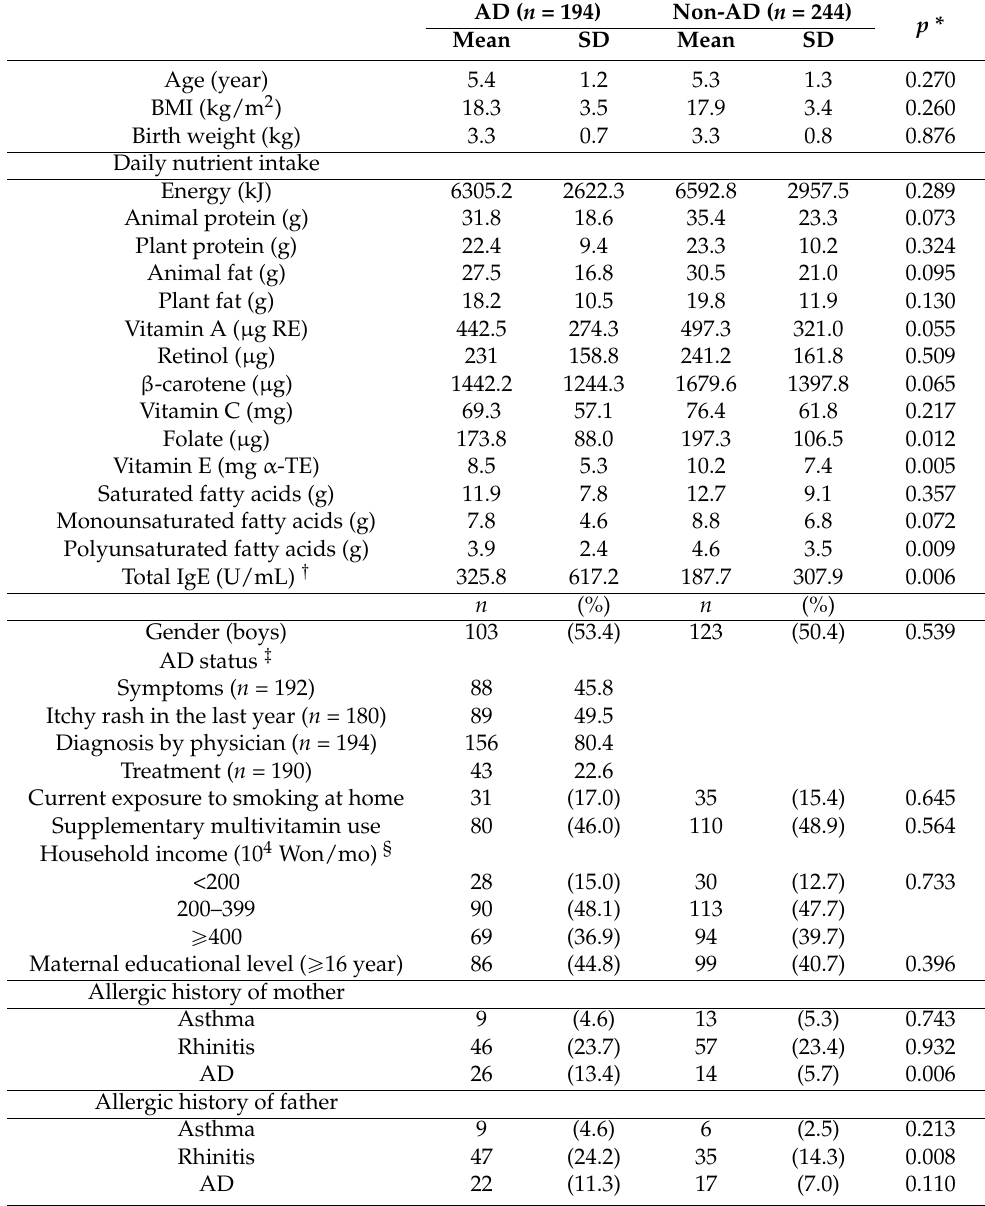
Table 4. Associations of nutrient intakes and general characteristics with atopic dermatitis (AD) in young